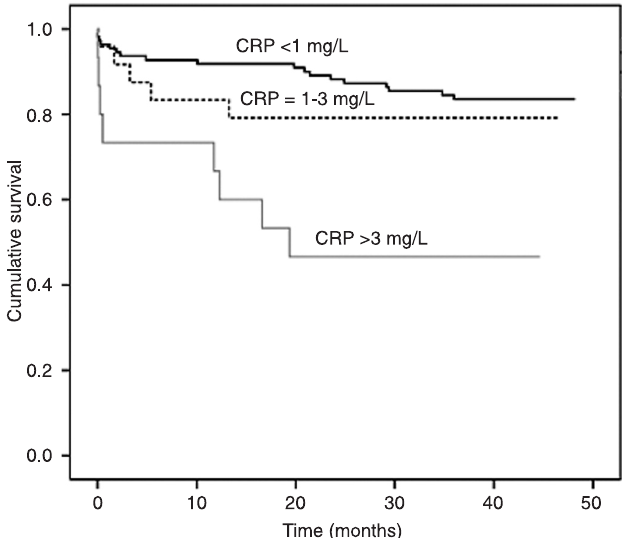
Figure 1. Kaplan Meier survival curve for patients in the three C-reac - tive protein (CRP) groups (<1, 1-3 and >3